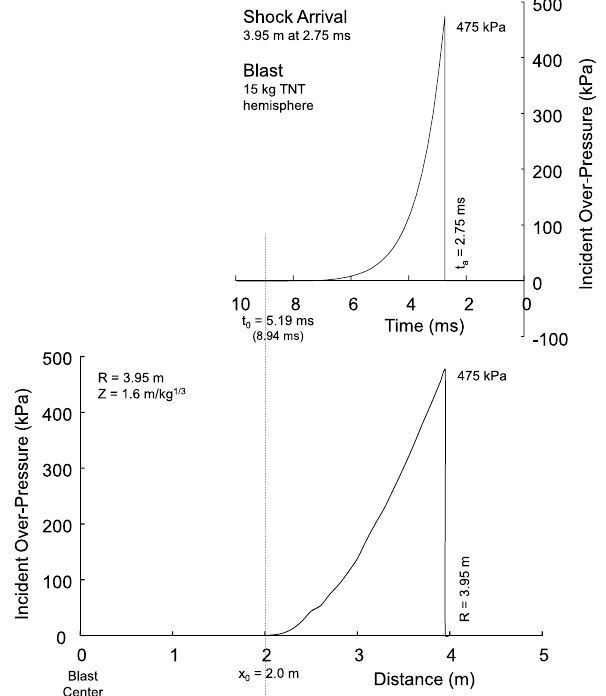
Figure 7. Time and special distribution of shock wave for 3.95 m stand-off distance with 15 kg hemispherical